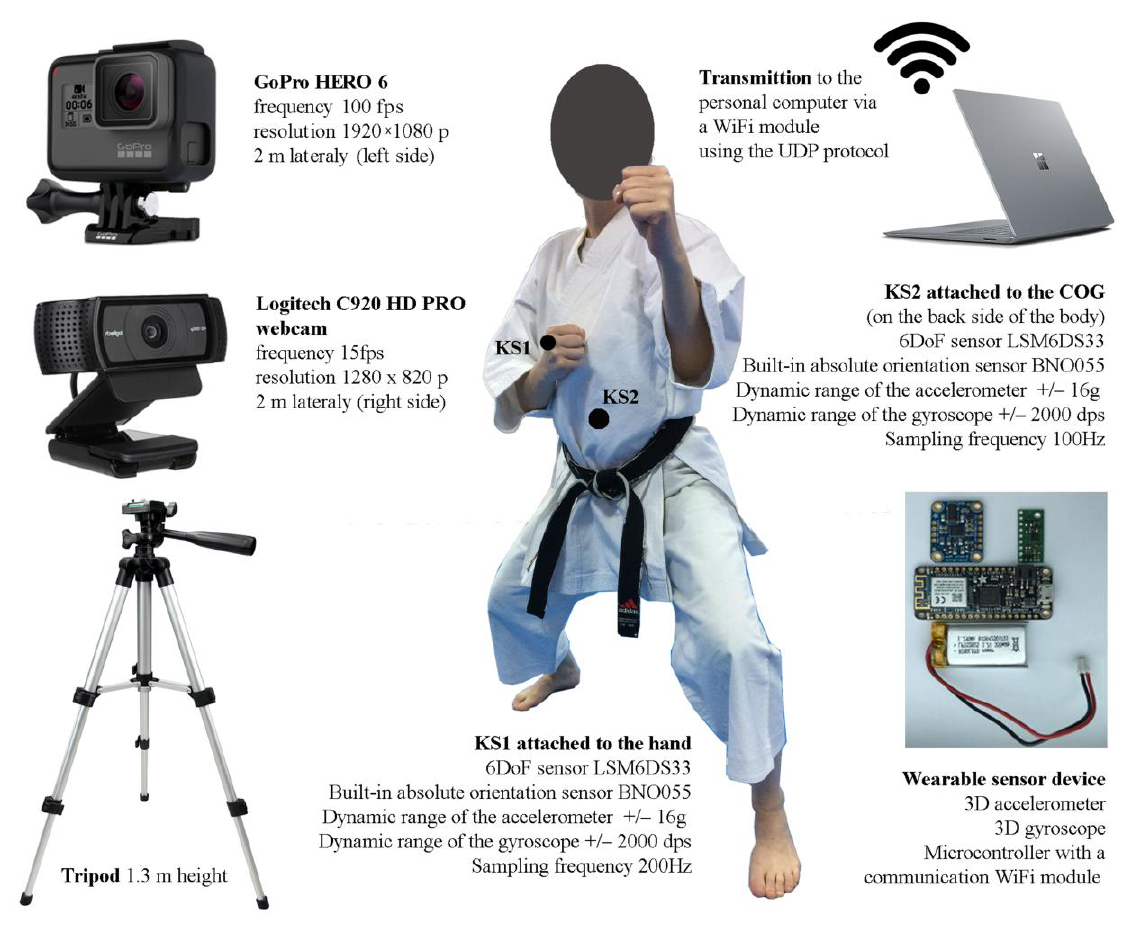
Figure 1. The experimental set-up included two cameras and a laptop wirelessly connected to two sensors attached to the athlete.